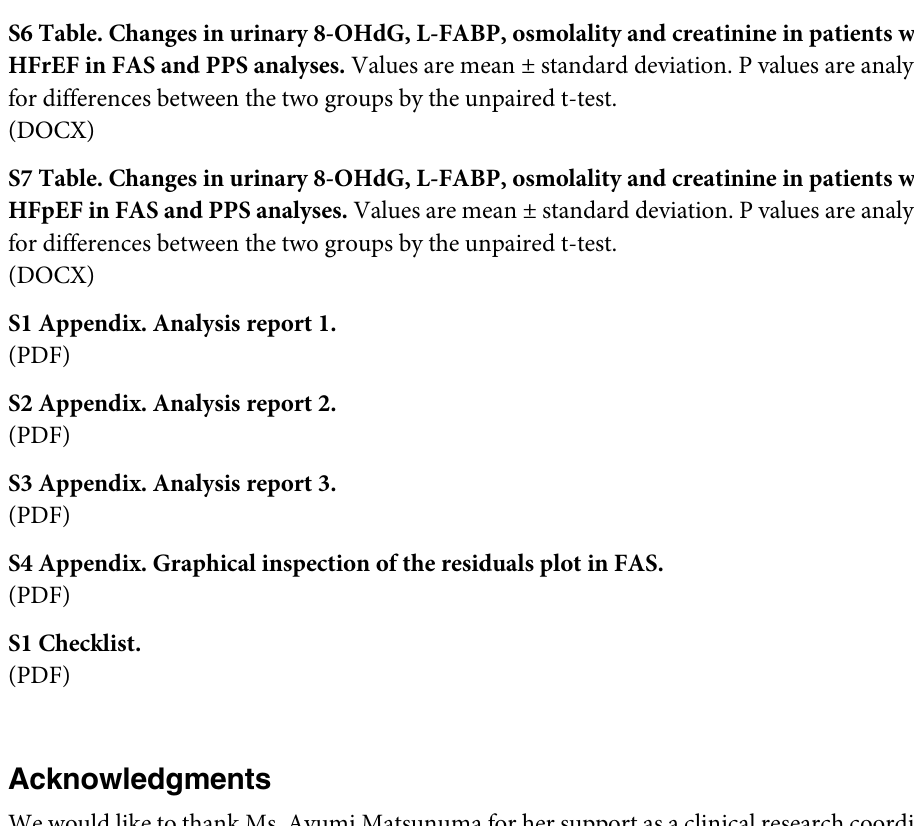
S1 Table. Detailed observations/measurements. S2 Table. Changes in study endpoints in PPS analysis. Values are mean ± standard devia- tion. P values are analyzed for differences between the two groups by the unpaired t-test. S3 Table. Correlations between percent change in NT-proBNP and BNP levels and between FMD and RHI values in FAS and PPS analyses. For correlation analyses, Pearson’s product-moment correlation coefficient or Spearman’s’ rank-correlation coefficient was calcu- lated to assess significance. S4 Table. Changes in NT-proBNP level and echocardiographic parameters in patients with HFrEF in FAS and PPS analyses. Values are mean ± standard deviation. P values are analyzed for differences between the two groups by the unpaired t-test. S5 Table. Changes in NT-proBNP level and echocardiographic parameters in patients with HFpEF in FAS and PPS analyses. Values are mean ± standard deviation. P values are analyzed for differences between the two groups by the unpaired t-test. S6 Table. Changes in urinary 8-OHdG, L-FABP, osmolality and creatinine in patients with HFrEF in FAS and PPS analyses. Values are mean ± standard deviation. P values are analyzed for differences between the two groups by the unpaired t-test. S7 Table. Changes in urinary 8-OHdG, L-FABP, osmolality and creatinine in patients with HFpEF in FAS and PPS analyses. Values are mean ± standard deviation. P values are analyzed for differences between the two groups by the unpaired